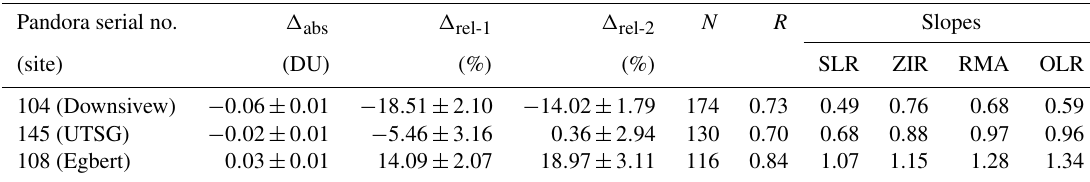
Table A2. TROPOMI ECCC vs. Pandora total column NO 2 , using the standard approach. Pandora serial no.